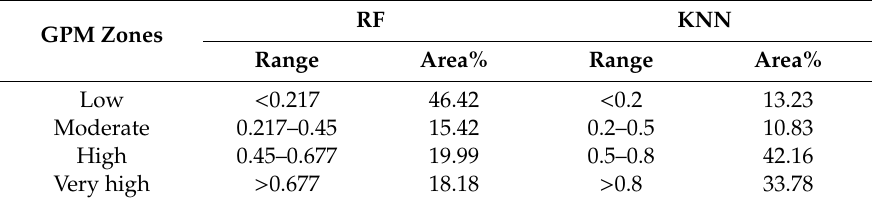
Table 5. Percentage distribution of susceptibility classes in the KNN and RF models.